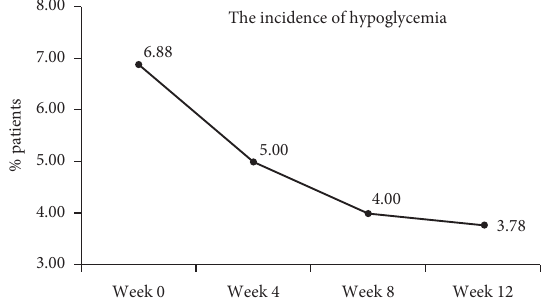
Figure 4: Incidence of hypoglycemia across the time periods. The incidence of hypoglycemic episodes showing the percentage of patients with blood glucose < 3.9mmol/L on the LCCP platform.